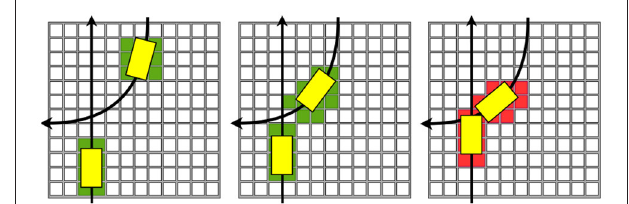
FIGURE 4 | An example of a conflict between two